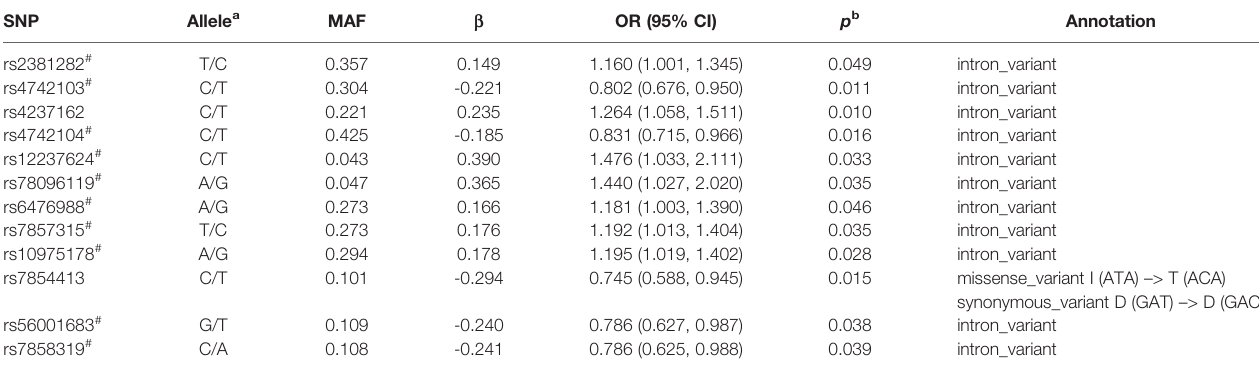
TABLE 2 | PDCD1LG2 SNPs associated with lung adenocarcinoma